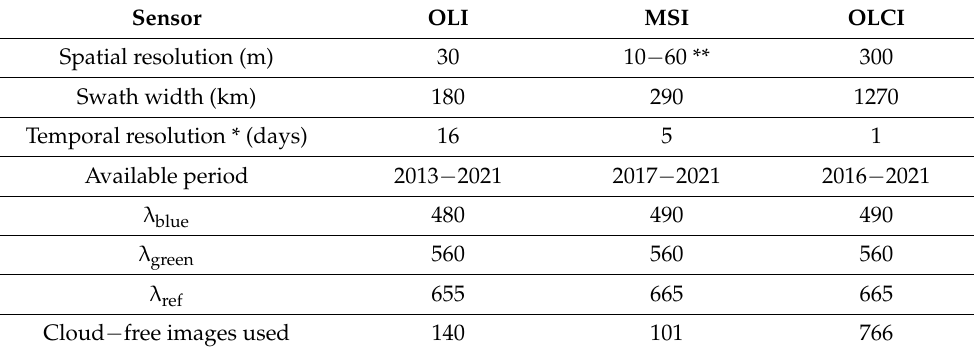
Table 1. Specifications of the Landsat-8 OLI, Sentinel-2 MSI, and Sentinel-3 OLCI data used for the study. The number of cloud-free images available during the period of interest is specified. * Nominal temporal resolution. Actual temporal resolution depends on the cloudiness of the study area. ** MSI data was resampled to 30 m to fit with the resolution of OLI data. Sensor OLI MSI OLCI Spatial resolution (m) 30 10 − 60 ** 300 Swath width (km) 180 290 1270 Temporal resolution * (days) 16 5 1 Available period 2013 − 2021 2017 − 2021 2016 −